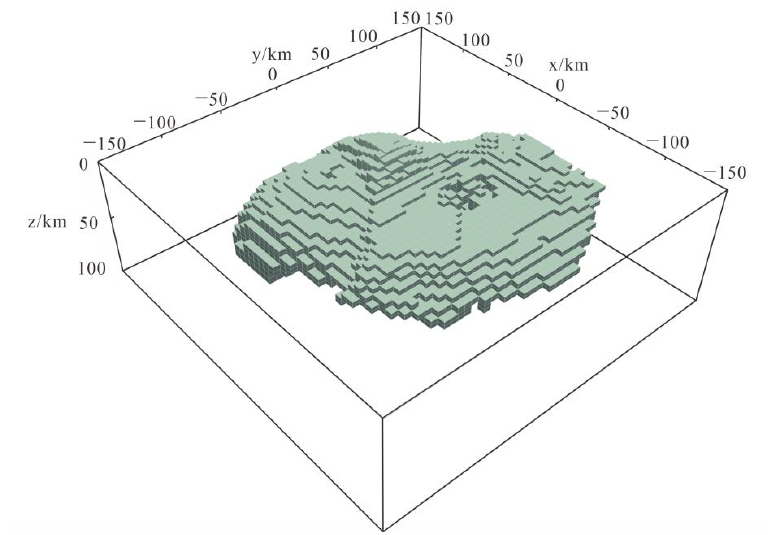
Figure 14. Diagram of the modified SEG/EAEG salt dome model (refer to [60]). The abnormal body